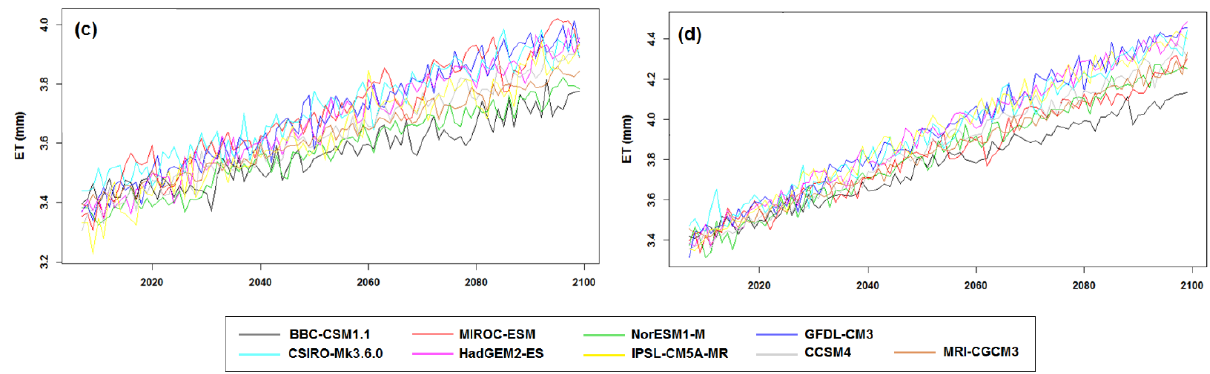
Figure 8. Projections of the annual average of daily ET at Alor Setar station for ( a ) RCP2.6; ( b ) RCP4.5; ( c ) RCP6.0; and ( d ) RCP8.5 for the period 2010–2099.